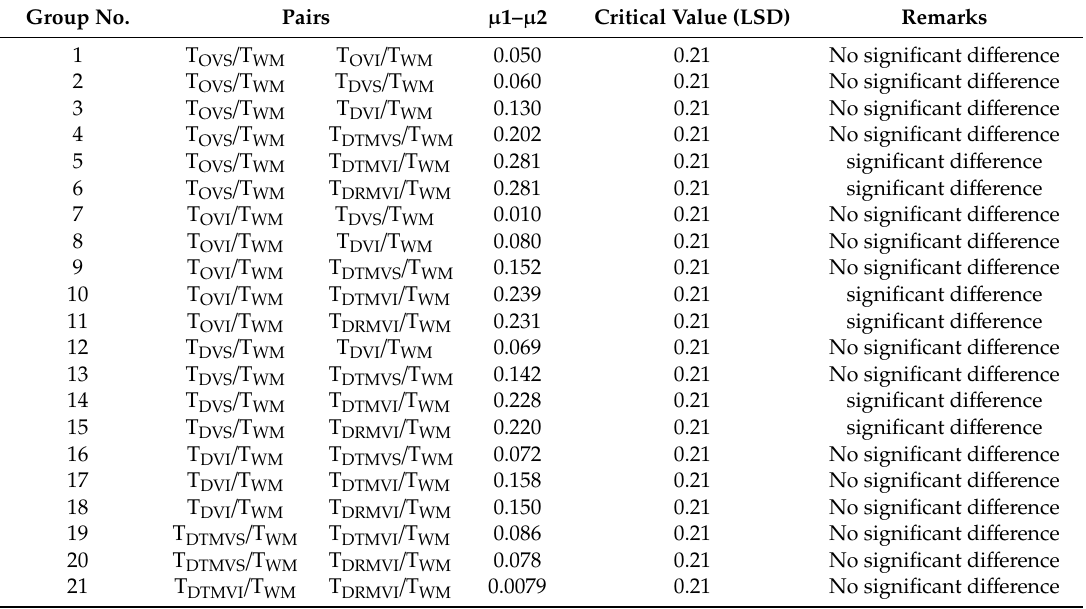
Table A1. Pairwise comparison between di ff erent groups. Group